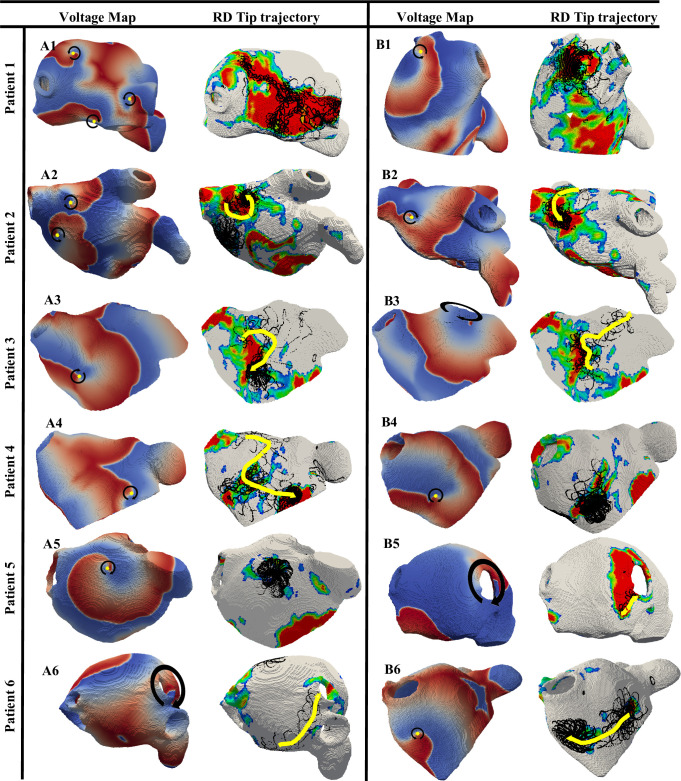
The anchoring of RDs to fibrotic patches in patient-specific LA models.For all the 6 AF patients (rows), sections A and B show the AF simulation outcomes for 2 different RD initiation sites. In each section, on the left are the colour-coded voltage maps and on the right, the respective RD trajectories (black) superimposed on the fibrosis distributions. The yellow arrows indicate the direction in which the RD drifted over 6s of the simulation. The colour map used in the figure is the same as Fig 6.